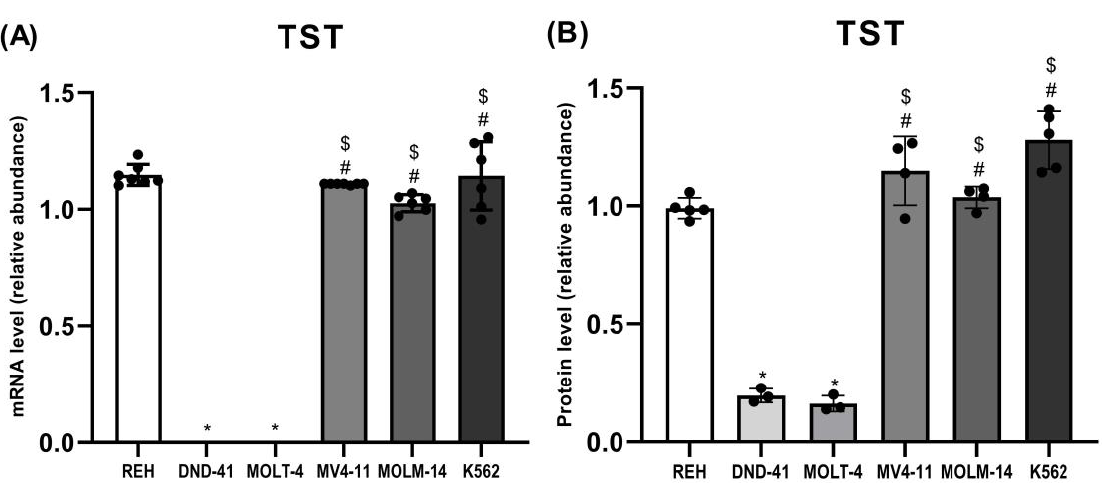
Figure 4. The expression on the mRNA ( A ) and protein ( B ) level of thiosulfate sulfurtransferase in leukemia cell lines (REH, DND-41, MOLT-4, MV4-11, MOLM-14, K562). β -Actin was used as a loading control. Quantification of the TST expression on mRNA level (RT-PCR method) and protein level (Western blotting method) was performed by densitometric analysis of the gels/blots and normalized to the internal loading control. The results are expressed as the mean ± SD of three or more independent experiments. Each mark represents p < 0.05 as followed: * versus REH; # versus DND-41; $ versus